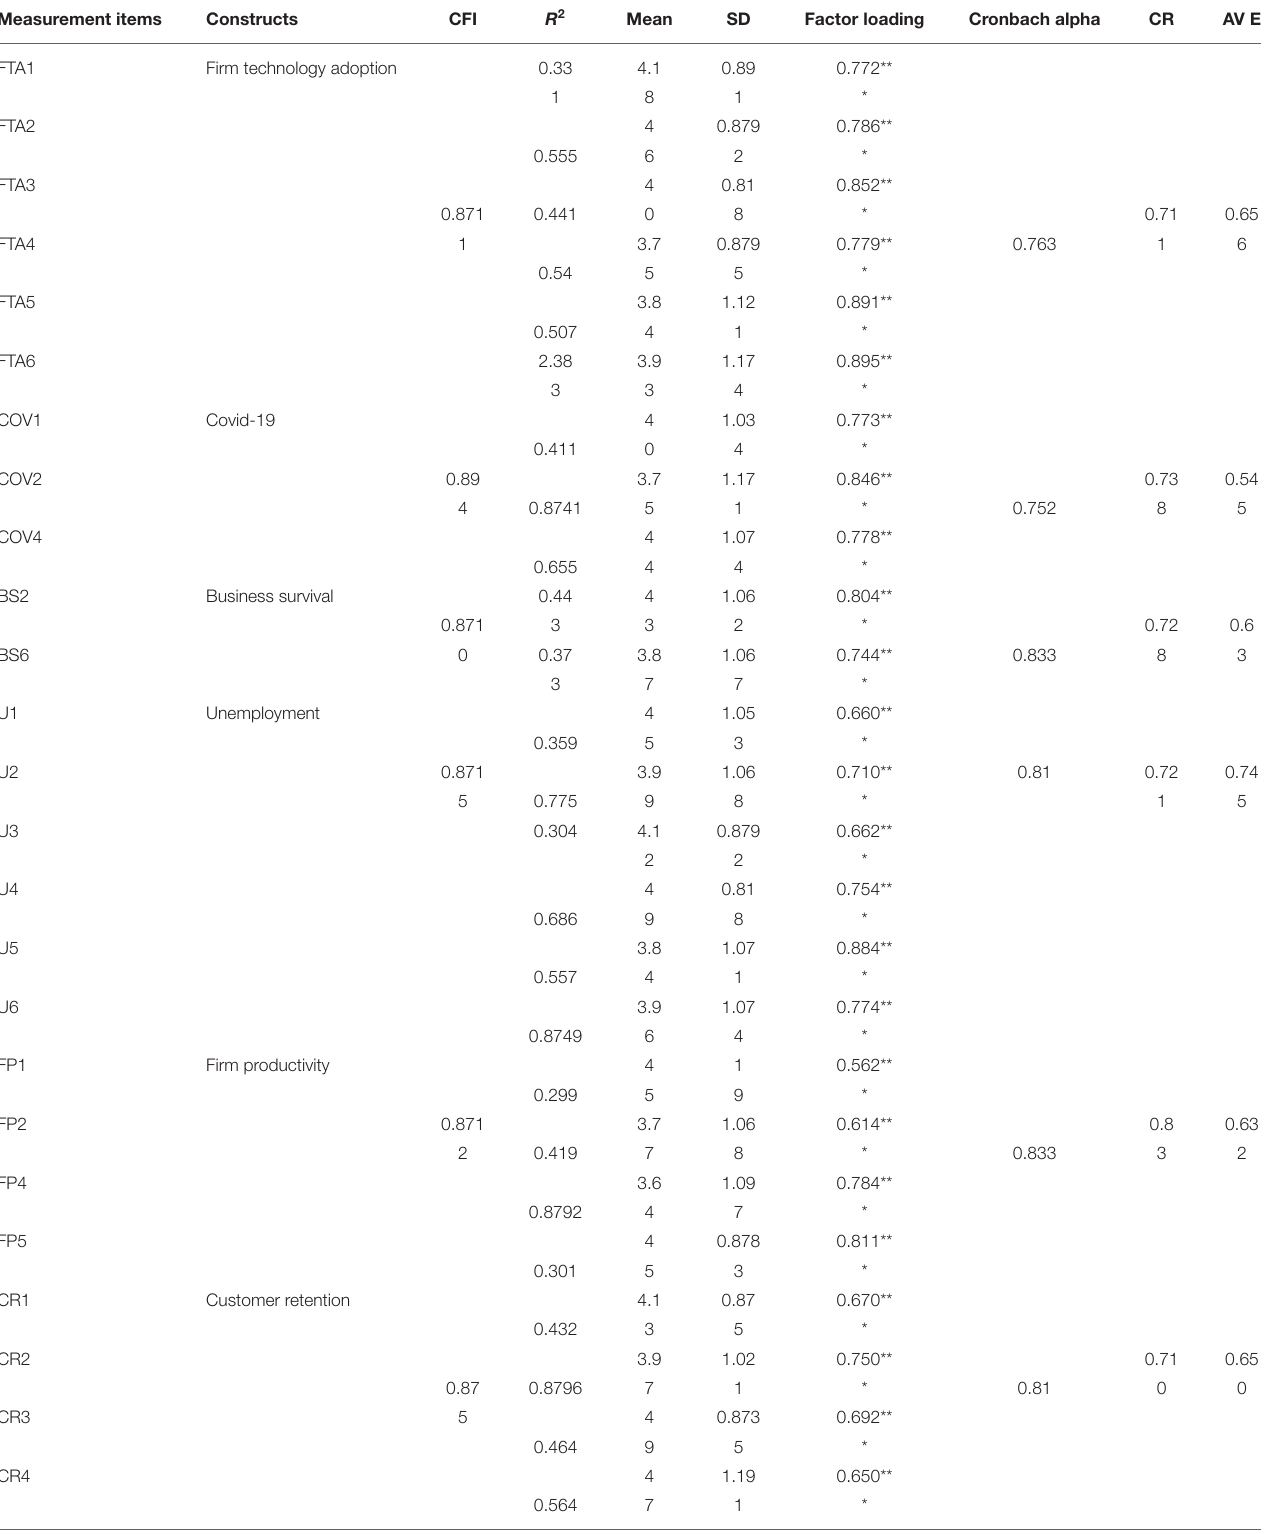
TABLE 3 | Dimension CR, AVE, CFI models, and Chi-square test values. Measurement